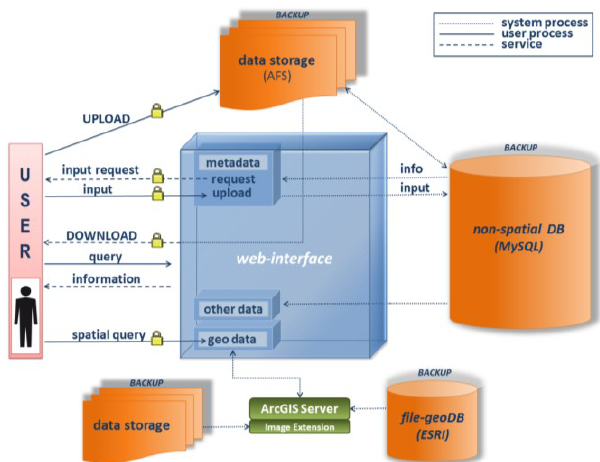
Figure 1. TR32DB design (modified after Curdt et al., 2011)